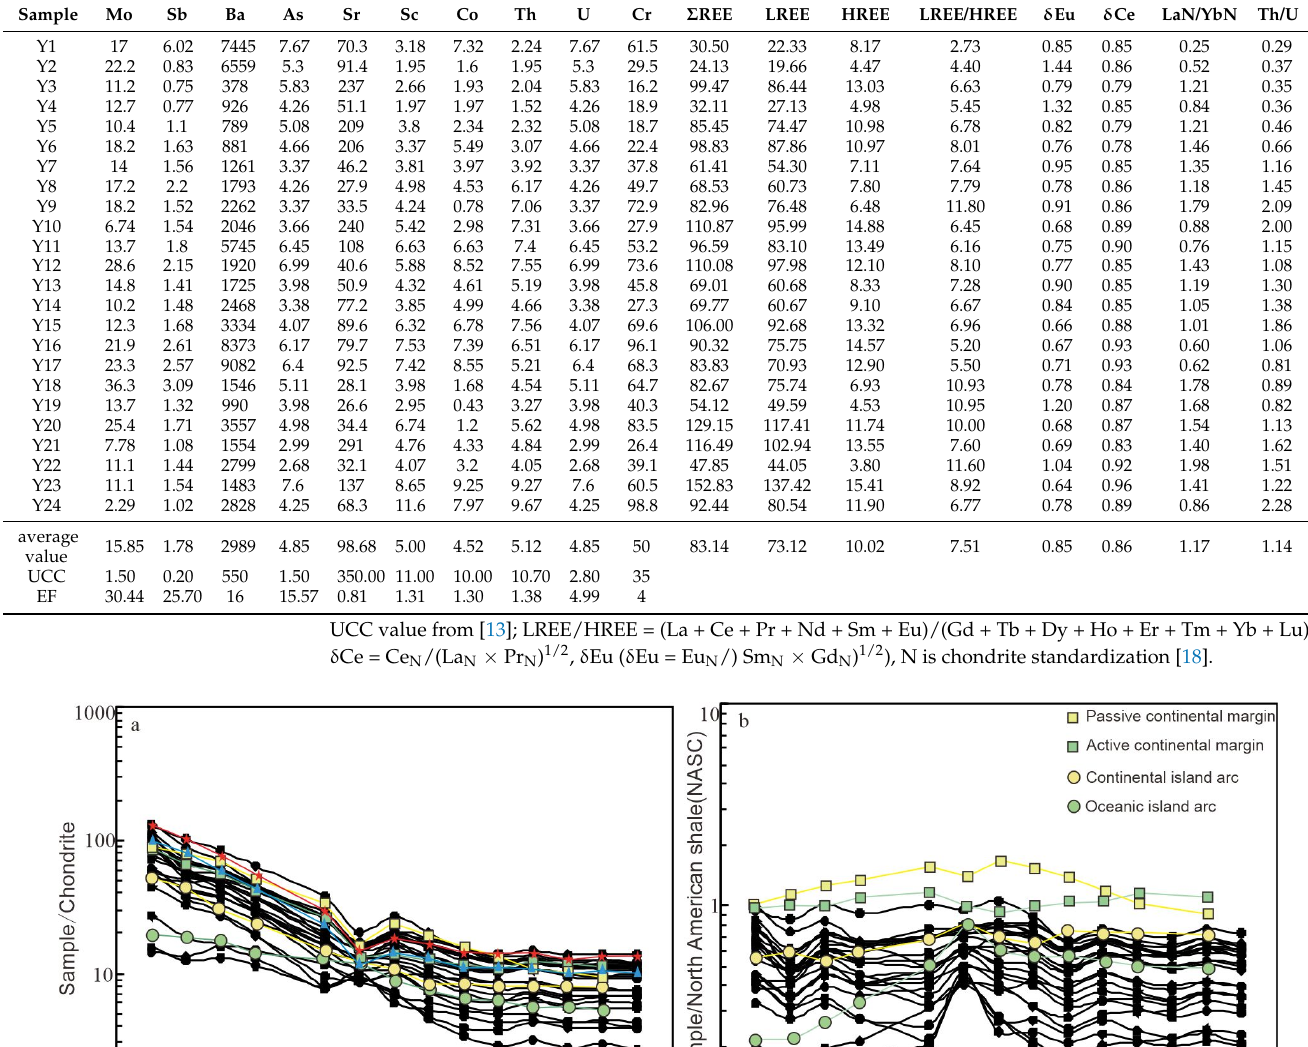
Table 3. Trace element and rare element (10 − 6 ) abundances and some associated parameters of Longmaxi mudstones from the Yanyuan Basin.